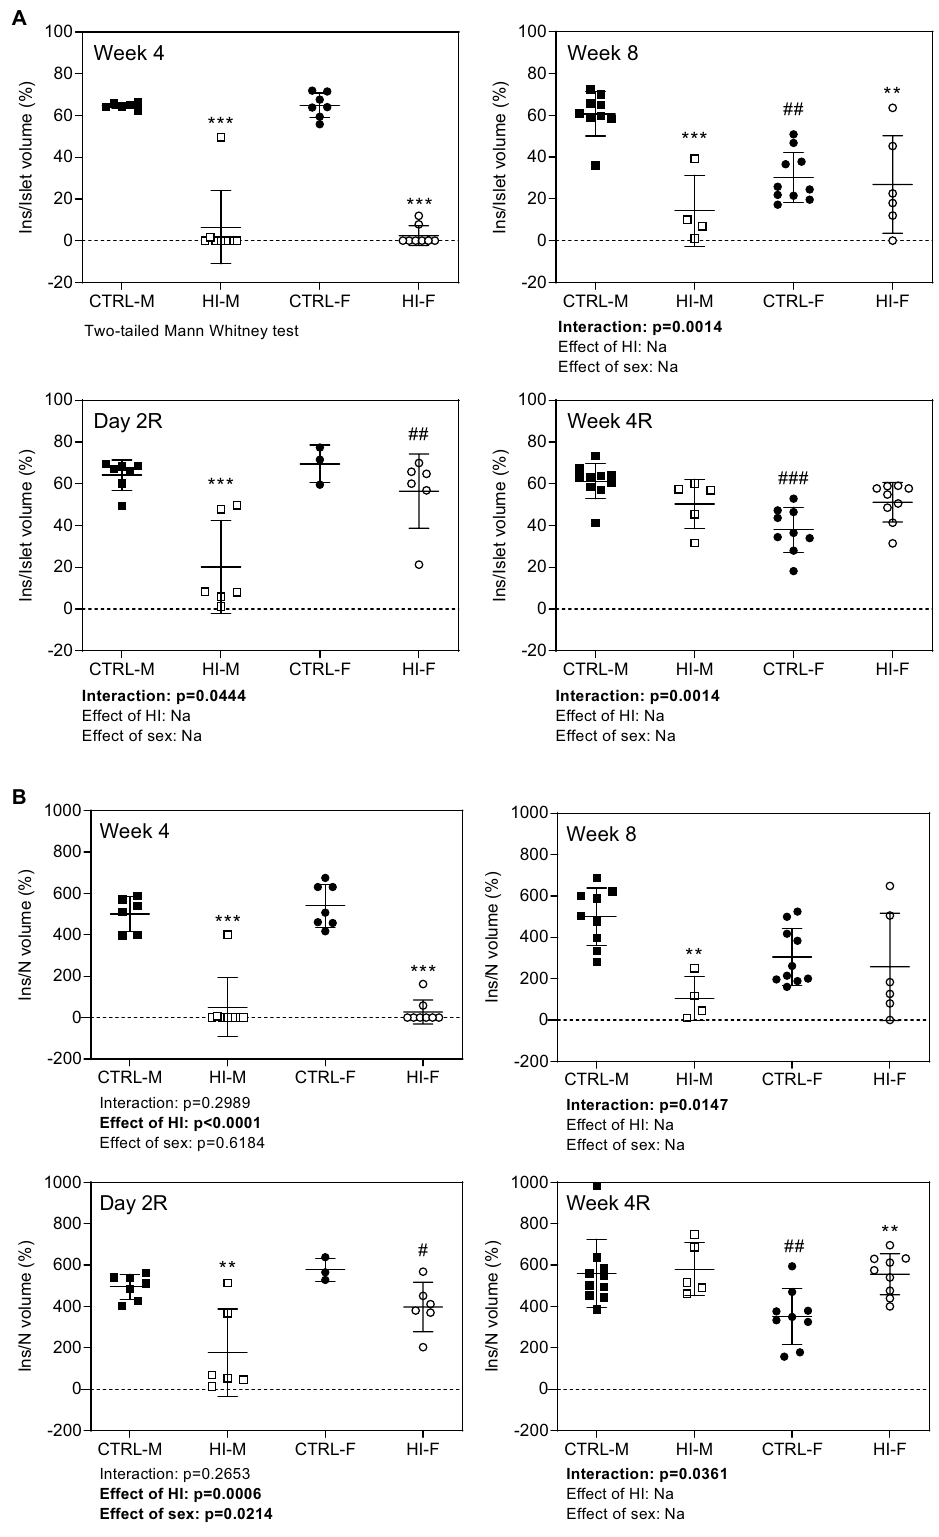
Figure 6. Relative insulin to islet and β-cell nucleus volume, individual (symbols) and means ± SDs. ( A ) Relative insulin to islet volume, ( B ) Relative insulin to β-cell nucleus volume. Week 4 : CTRL-M, n = 6; HI-M, n = 8; CTRL-F, n = 7; HI-F, n = 8. Week 8 : CTRL-M, n = 9; HI-M, n = 4; CTRL-F, n = 10; HI-F, n = 6. Day 2R : CTRL-M, n = 7; HI-M, n = 6; CTRL-F, n = 3; HI-F, n = 6. Week 4R : CTRL-M, n = 10; HI-M, n = 5; CTRL-F, n = 9; HI-F, n = 9. * p < 0.05, ** p < 0.01, *** p < 0.001 versus control group for the same sex. # p < 0.05, ## p < 0.01 versus the corresponding group of the opposite sex. Abbreviations: HI, human insulin; Ins, insulin; N, nucleus; Na, not applicable; R, recovery (infusion-free